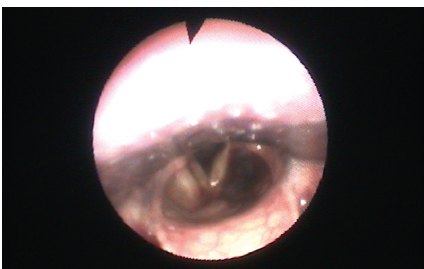
Figure 3: 1-week laryngeal fiberoscopy showing normal laryngeal placement and only a slight rosaceous coloration of the left ven- tricular